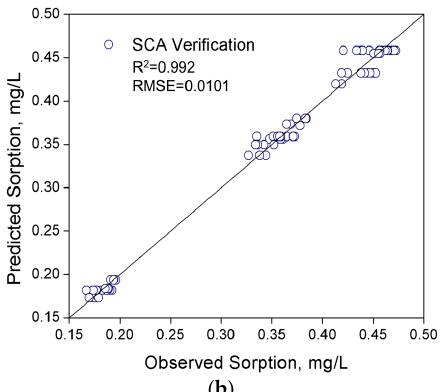
Figure 3. The calibration ( a ) and verification ( b ) of phenanthrene sorption data using the stepwise-cluster analysis (SCA) method (Run No. 3).